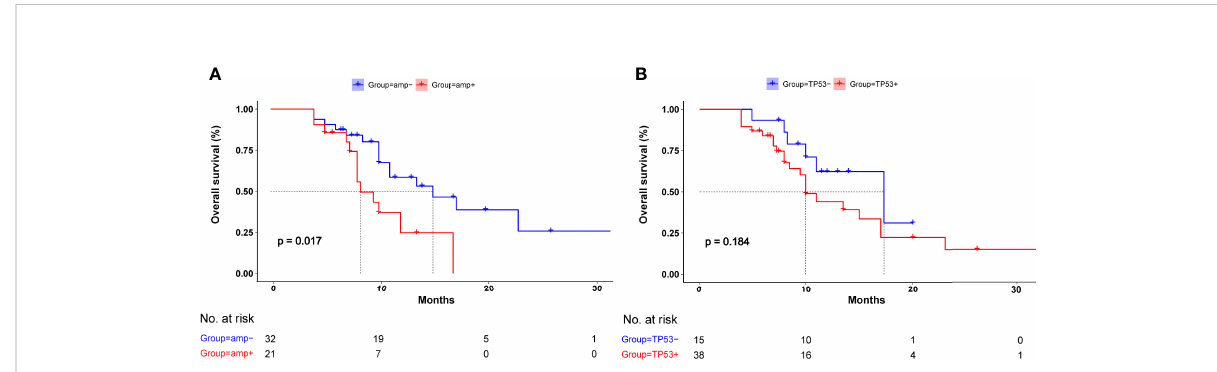
FIGURE 3 Kaplan – Meier analysis of overall survival in patients with and without (A) epidermal growth factor receptor (EGFR) ampli fi cation and (B) TP53 mutation. (A) Median overall survival was signi fi cantly poorer in patients with than those without EGFR ampli fi cation ( p = 0.017). (B) Median overall survival was similar in patients with and without TP53